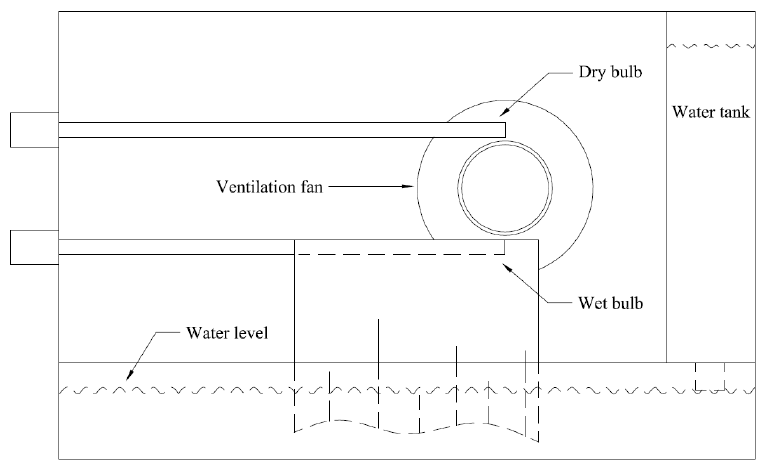
Figure 1. The structure of an aspirated psychrometer.